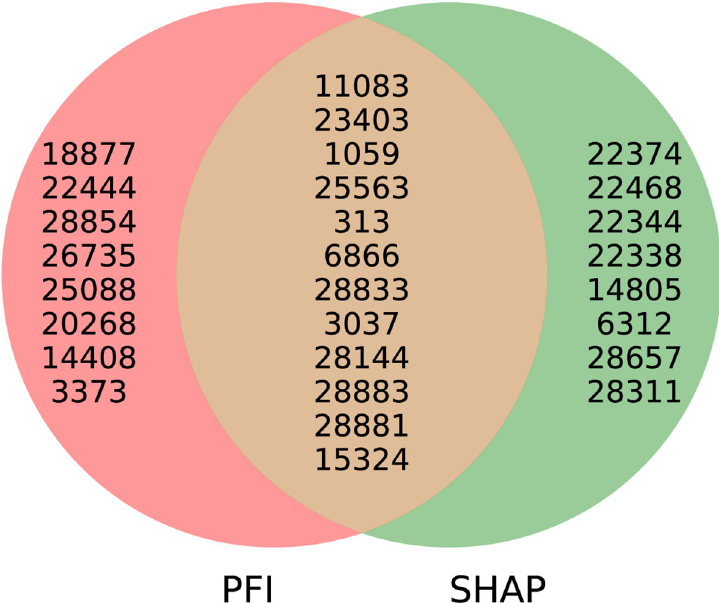
Fig 10. Analysis of the predicted features common to the PFI and SHAP methods. The top 12 mutations predicted by both methods are depicted (See Table 1 and main text for details).